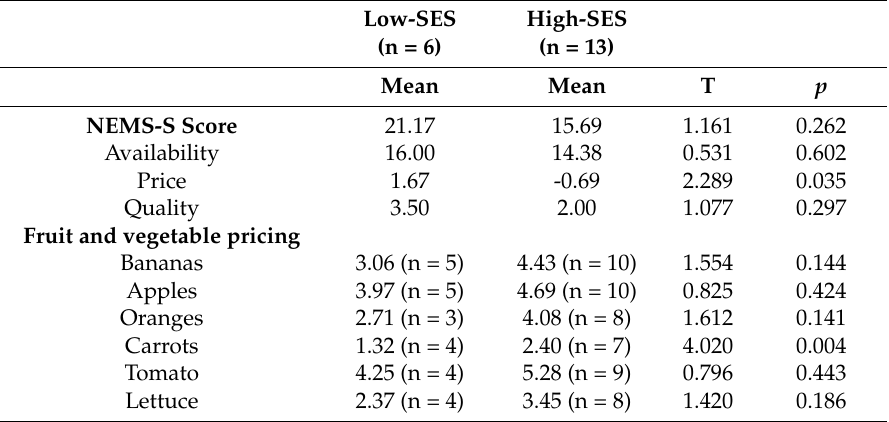
Table 2. Indicators of support for healthful eating by suburb SES for